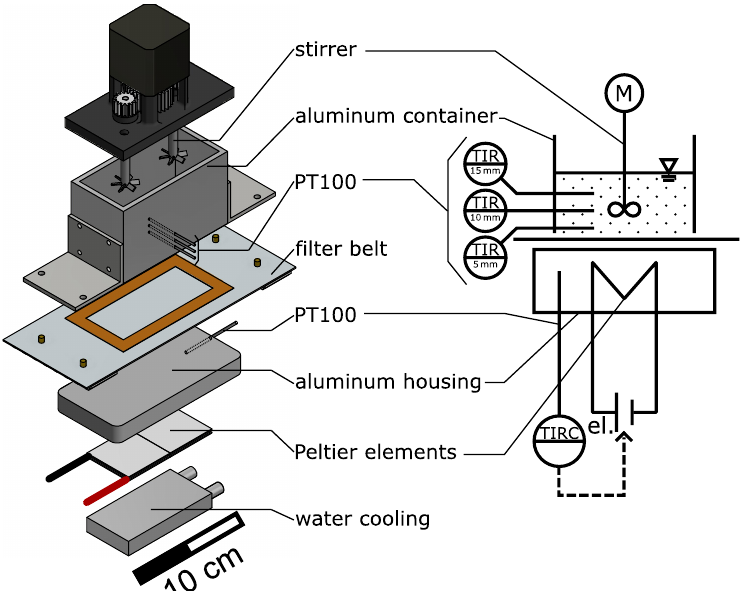
Figure 2. CAD representation and P&ID of the process container with temperature control. Tempera- ture sensors reach into the process medium at three different heights. Adapted from